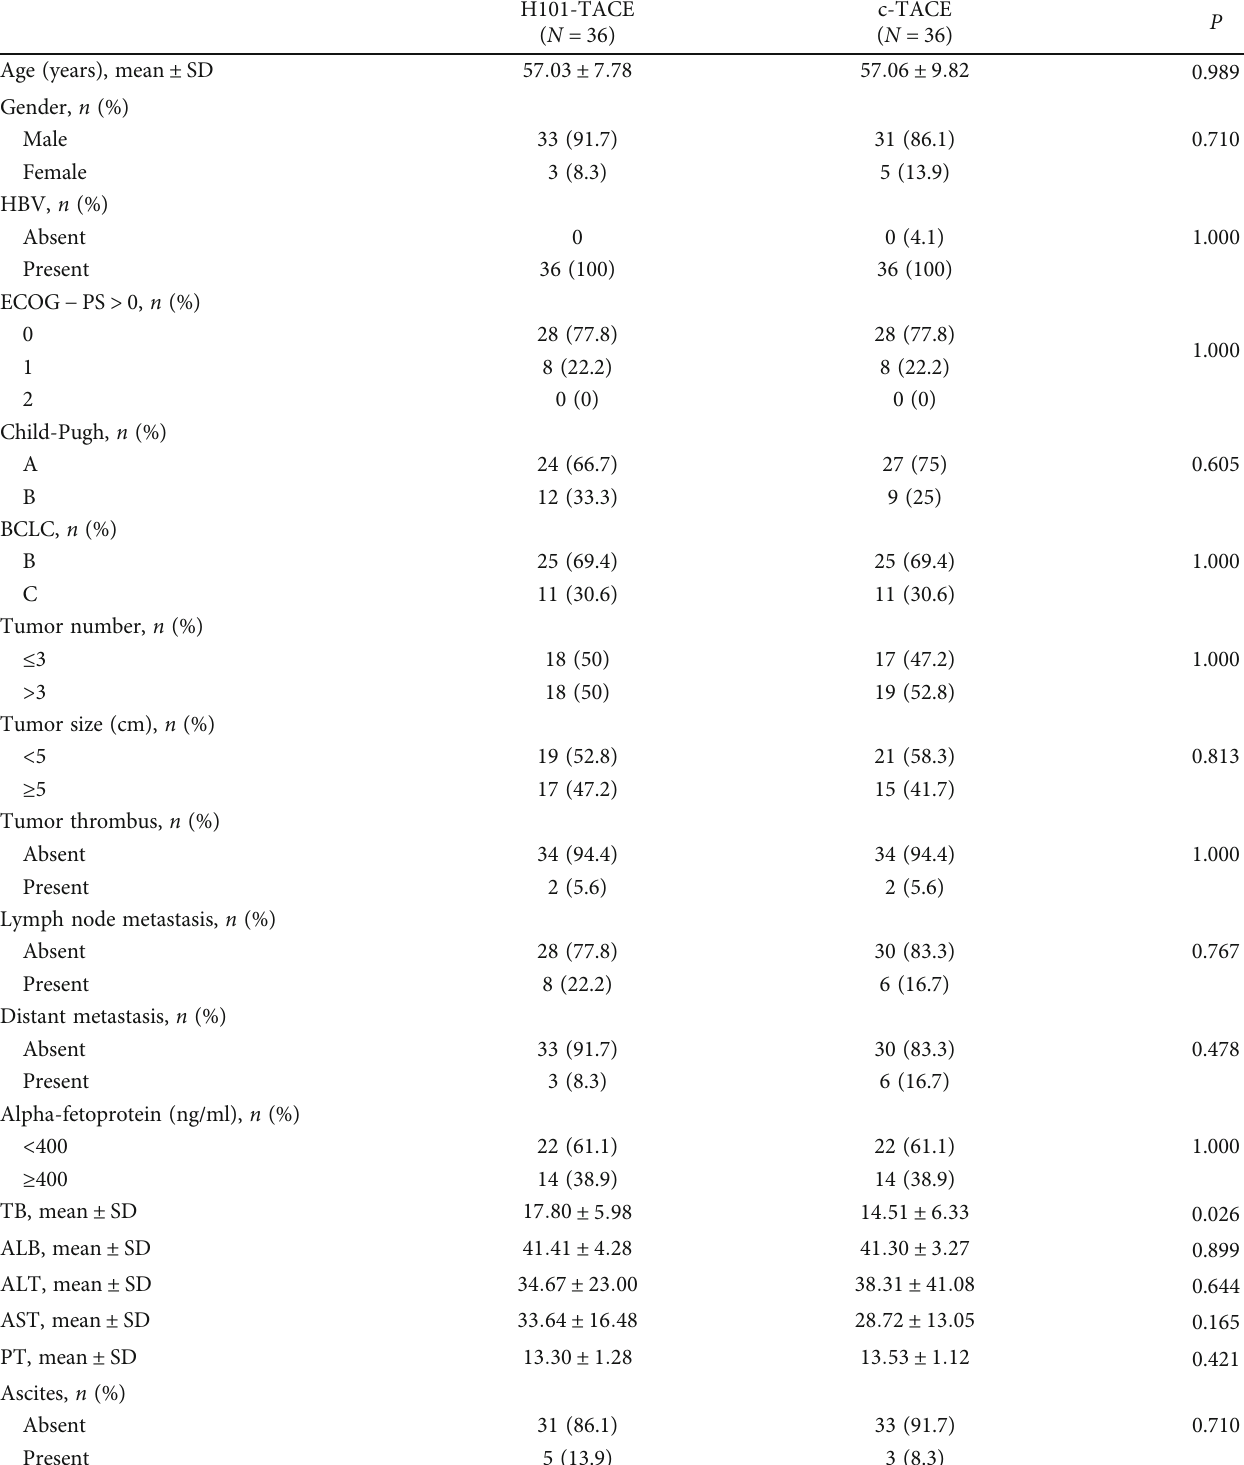
Table 2: Comparison of baseline characteristics between the two cohorts following